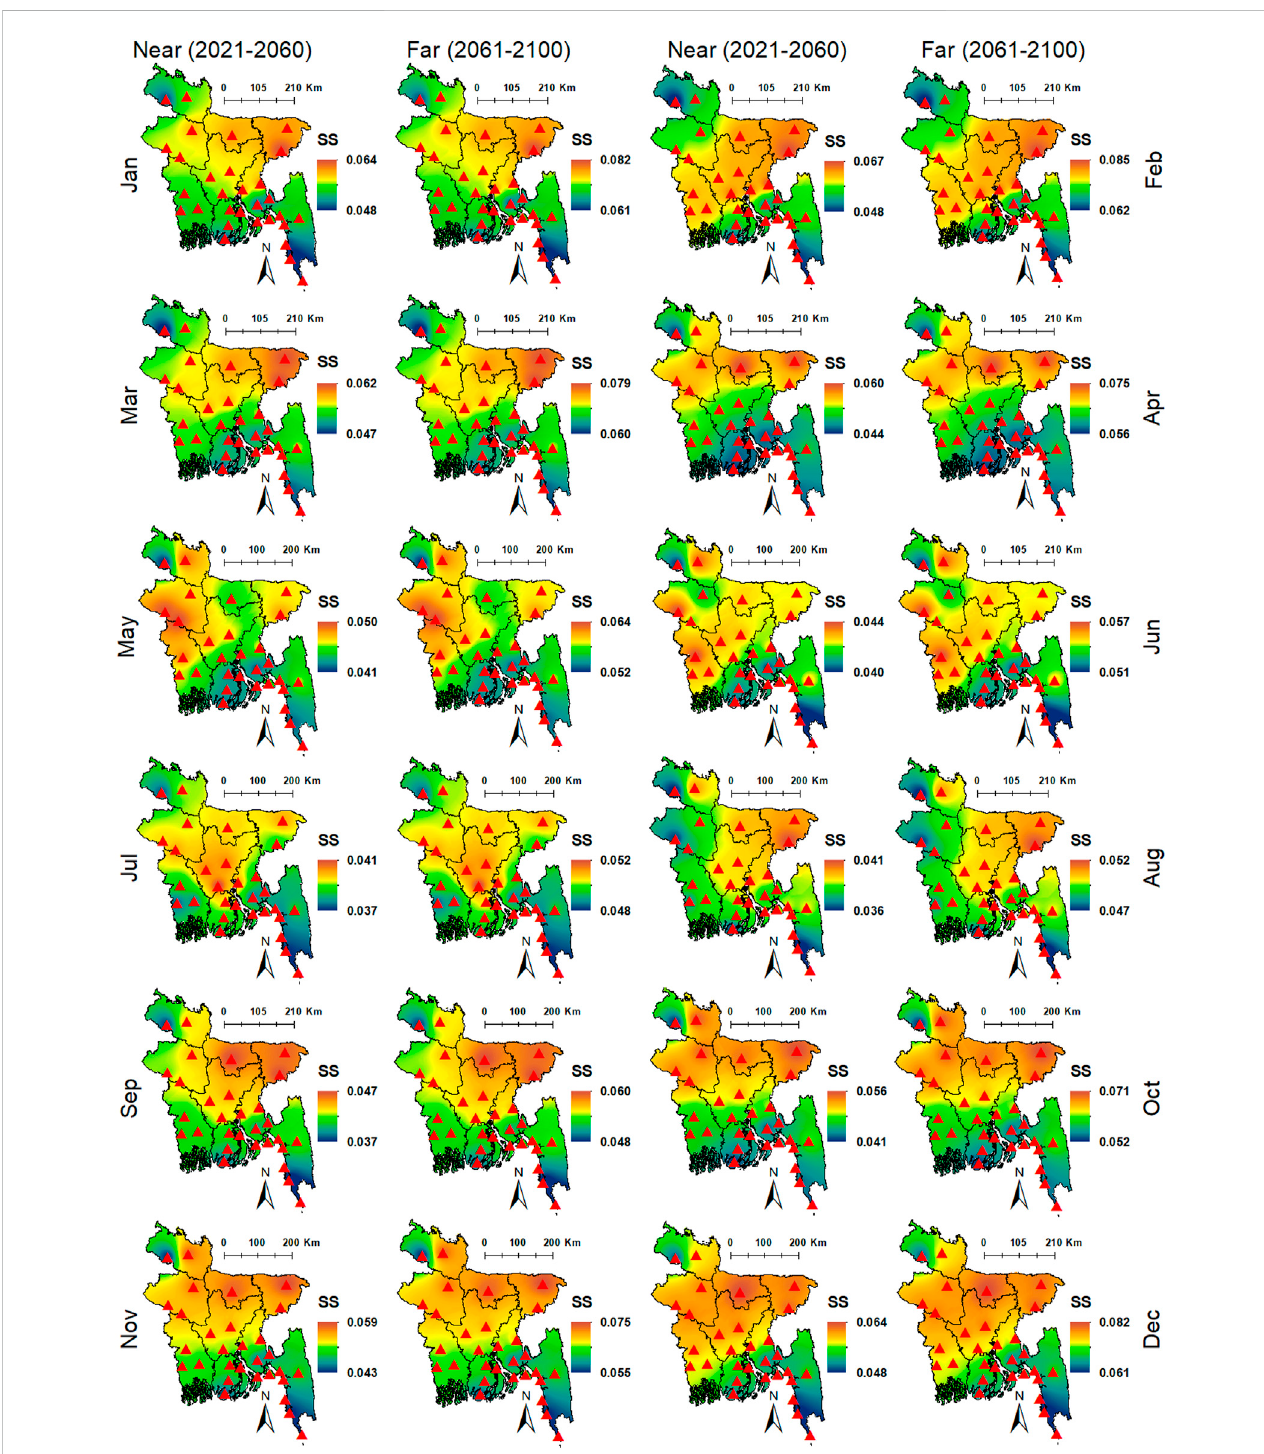
FIGURE 7 Same as Figure 6 but for the